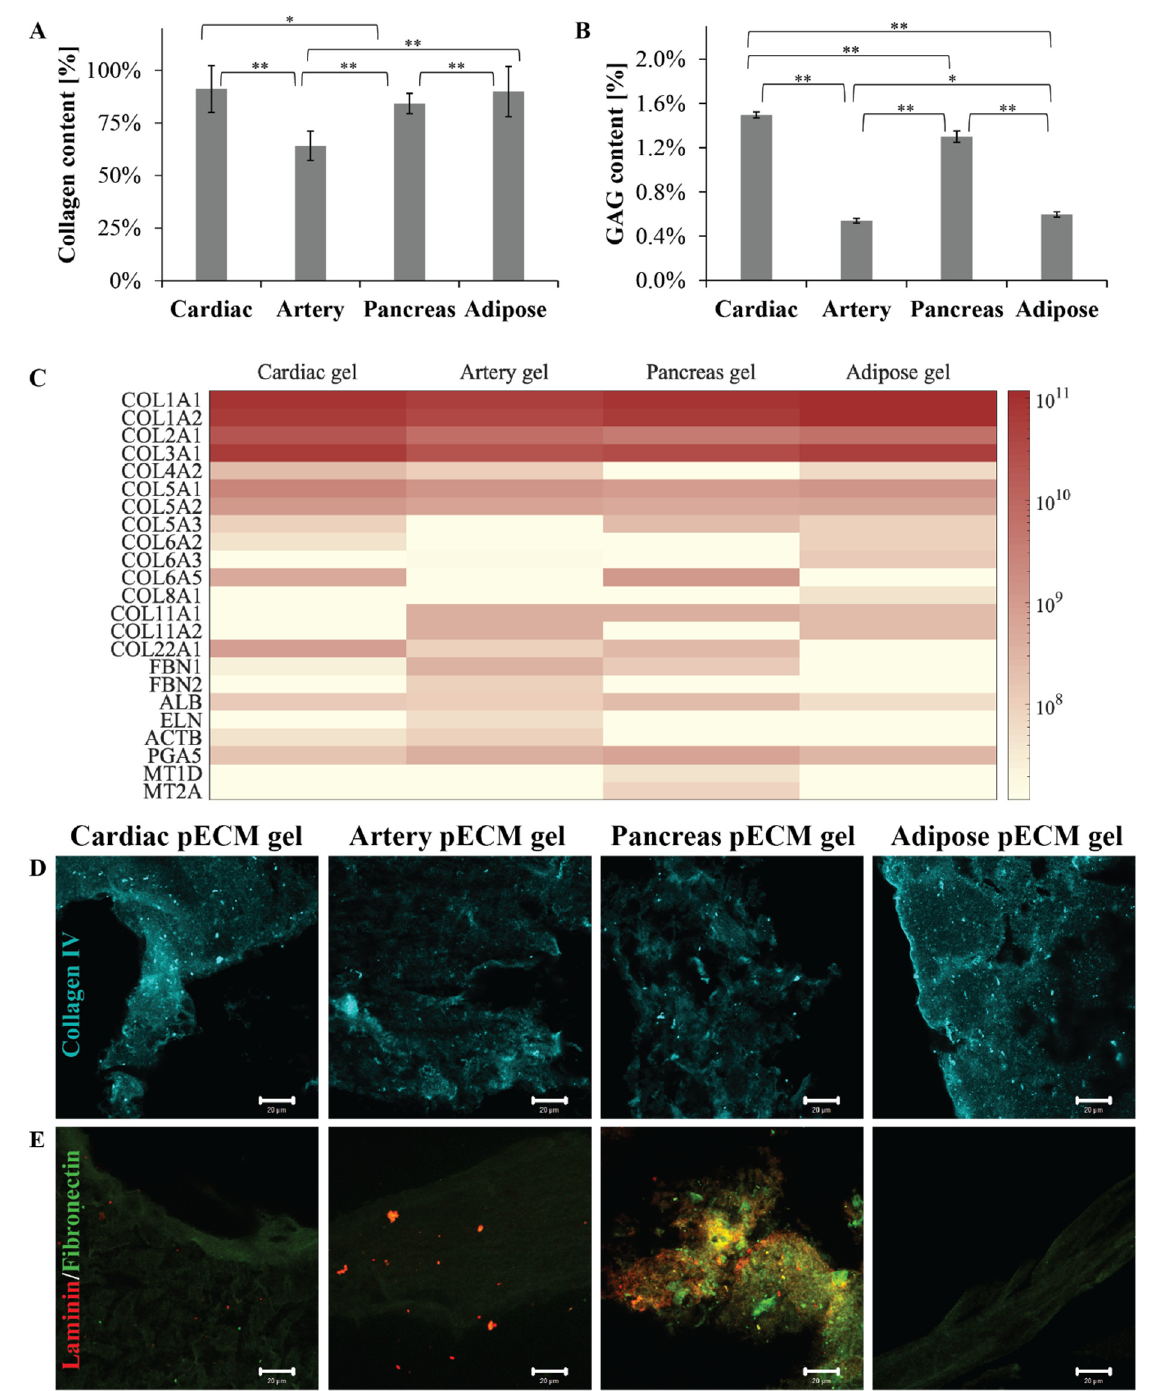
Figure 1. pECM hydrogels composition. ( A ) Collagen and ( B ) GAGs quantification in the different pECM hydrogels, presented as a percentage of total dry pECM of the hydrogels. * p < 0.05, ** p < 0.01 ( C ) Proteomic profile of the different pECM hydrogels presented as a heatmap for each hydrogel. The scale ranges from white to maroon where maroon represents a more abundant protein, according to LFQ calculated parameter. ( D , E ) Immunostaining of the different pECM hydrogels for collagen IV ( D , cyan), laminin, and fibronectin ( E , red and green, respectively). Scale bars, 20 μ m.